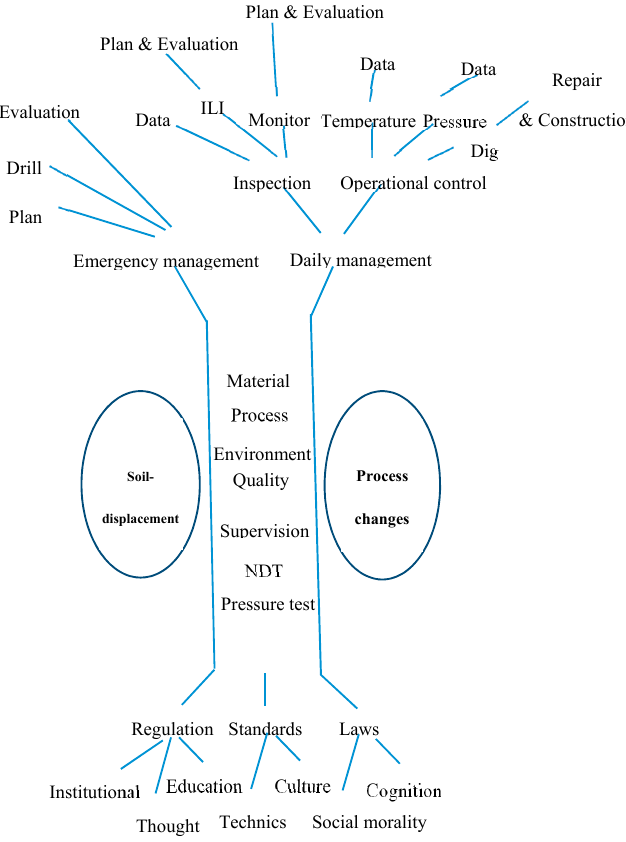
Figure 1. “Tree-type” accident-cause model for girth weld.